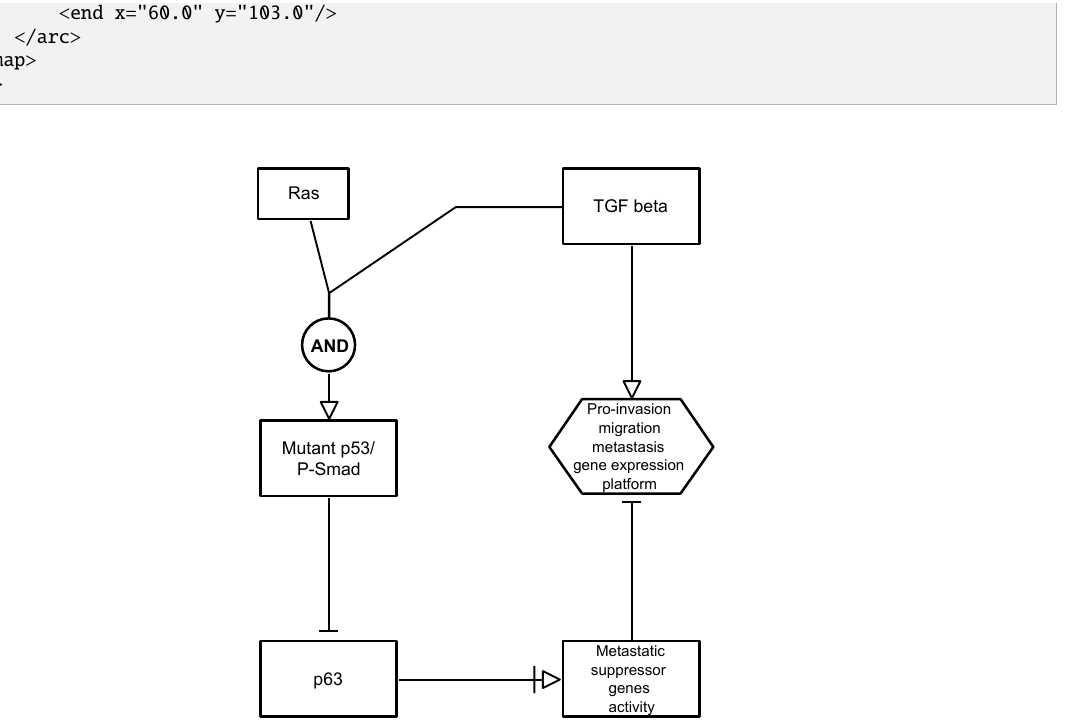
Figure 29: Regulation of TGF β –induced metastasis as described by Adorno et al.